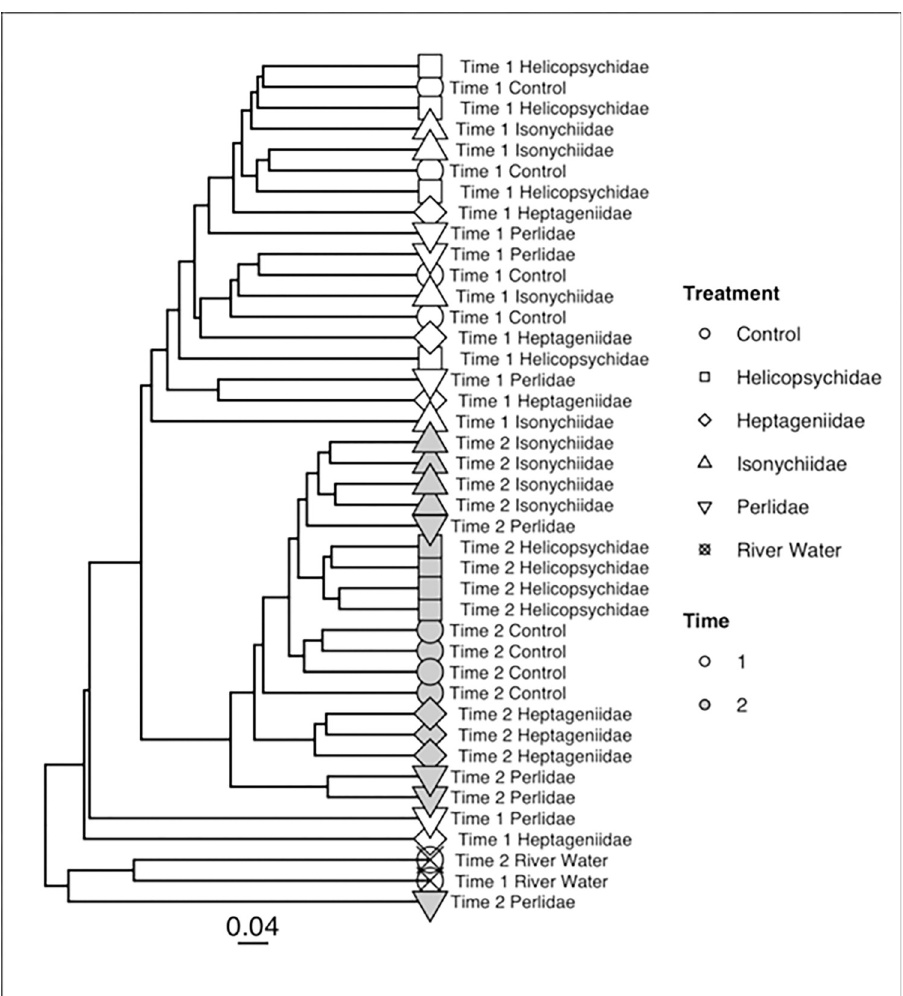
Fig 7. UPGMA diagram based on bacterial (16S) Bray-Curtis distances among lake sturgeon egg surface communities sampled during two time periods for each of 4 aquatic insect treatments, a no insect control, and stream water. Time 1 and Time 2 refer to 1 da and 4 da post fertilization,